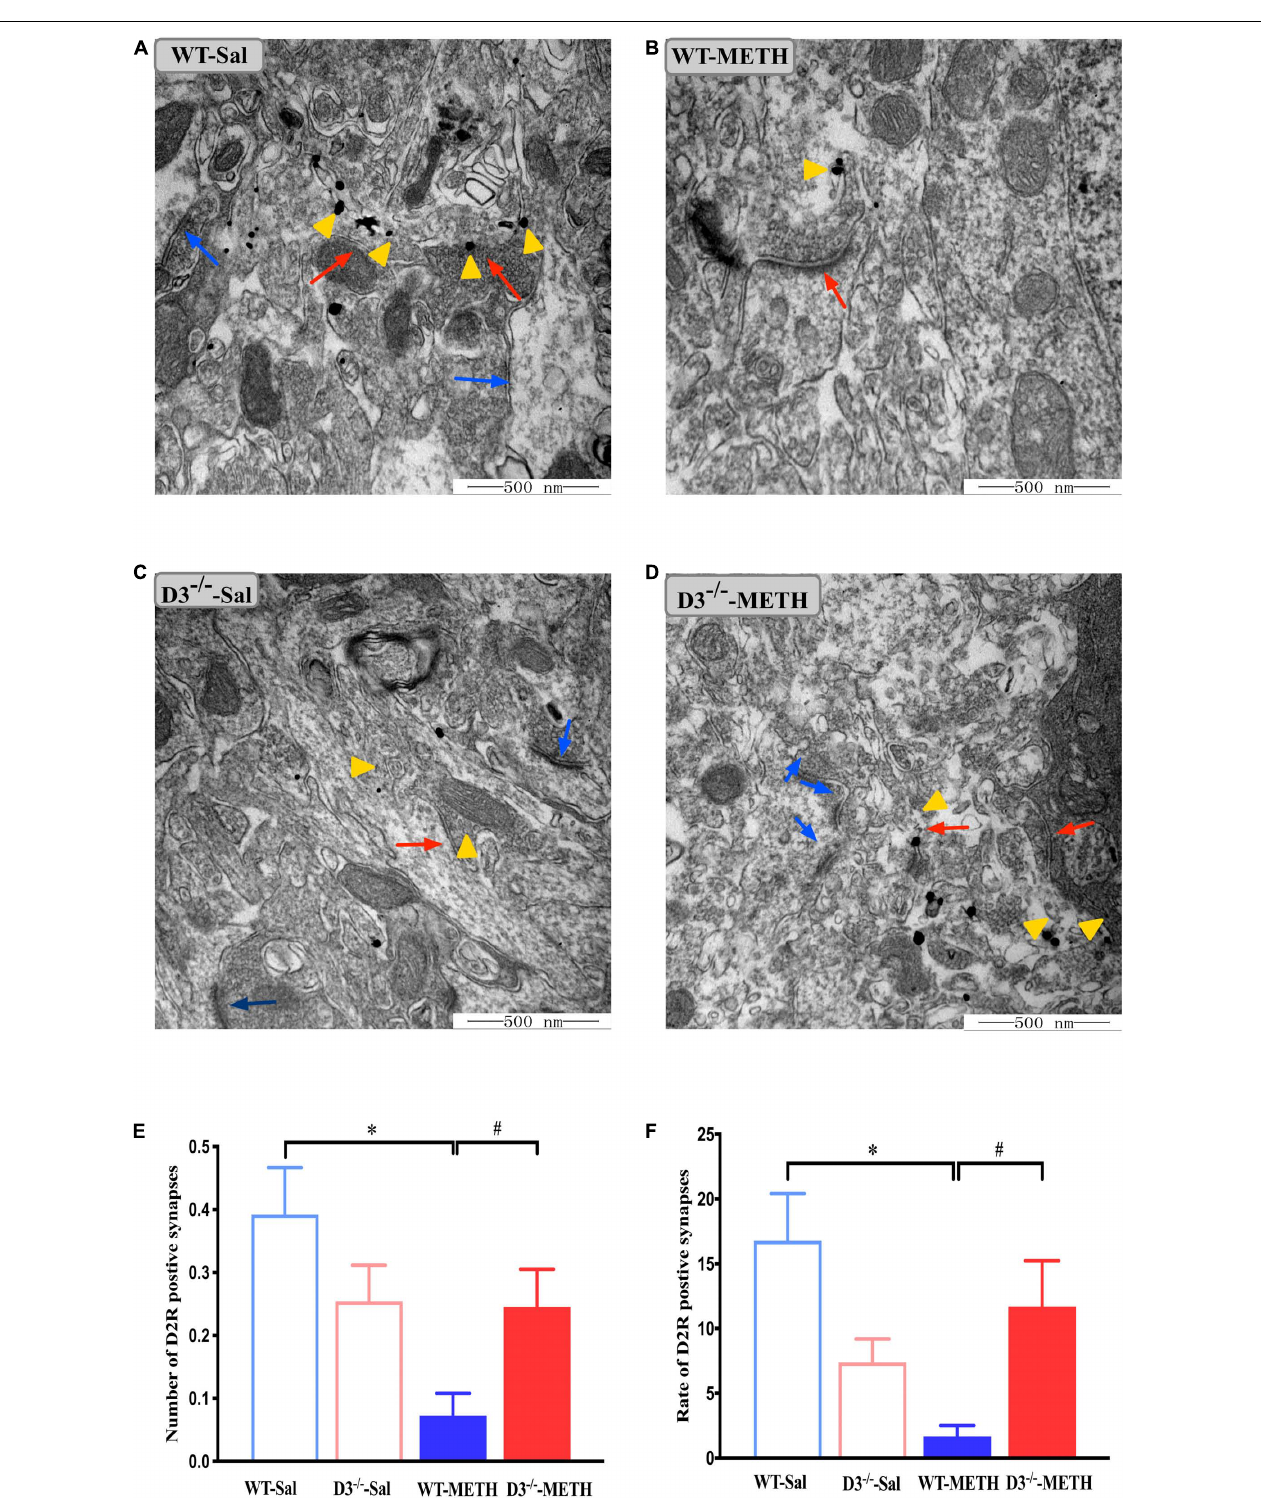
FIGURE 4 | Knockout of dopamine D3 receptor gene blocked the changes of dopamine D2 receptor-positive synapses in the NAcsh of METH-sensitized mice. (A–D) Ultrastructure photos showed synapses in the NAcsh of mice. The red arrows indicated the dopamine D2 receptor-positive synapses, the yellow arrows indicated the silver-intensified gold particles, and the blue arrows indicated the non-positive synapses. Scale bars = 500 nm. (E,F) Quantification of the number (E) and rate (F) of the dopamine D2 receptor-positive synapses of the four groups of mice ( n = 3 mice each). ∗ P < 0.05 compared with the same genotype in saline group; # P < 0.05 compared with same-dose WT mice. Values are presented as mean ± SEM. WT, wild type.